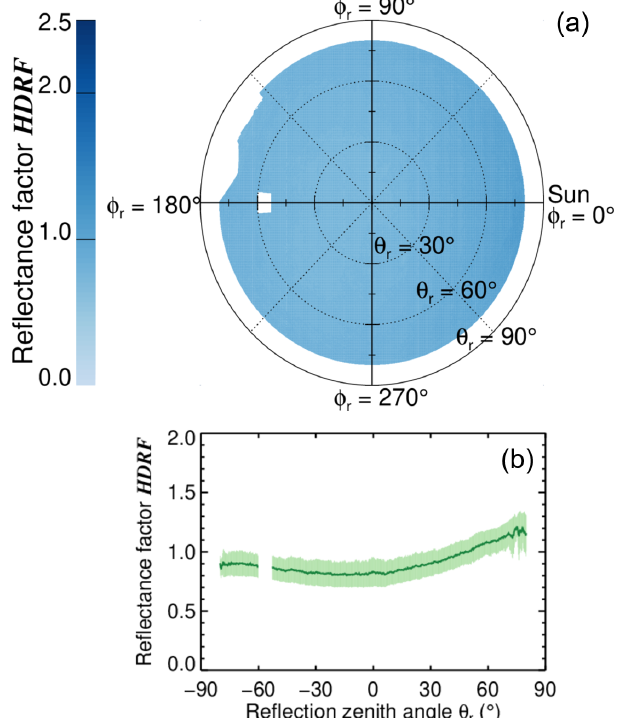
Figure 8. Same as Fig. 6 but for sea ice and without the mean pixel- based sea ice fraction and the mean pixel-based sunglint fraction in (b) .